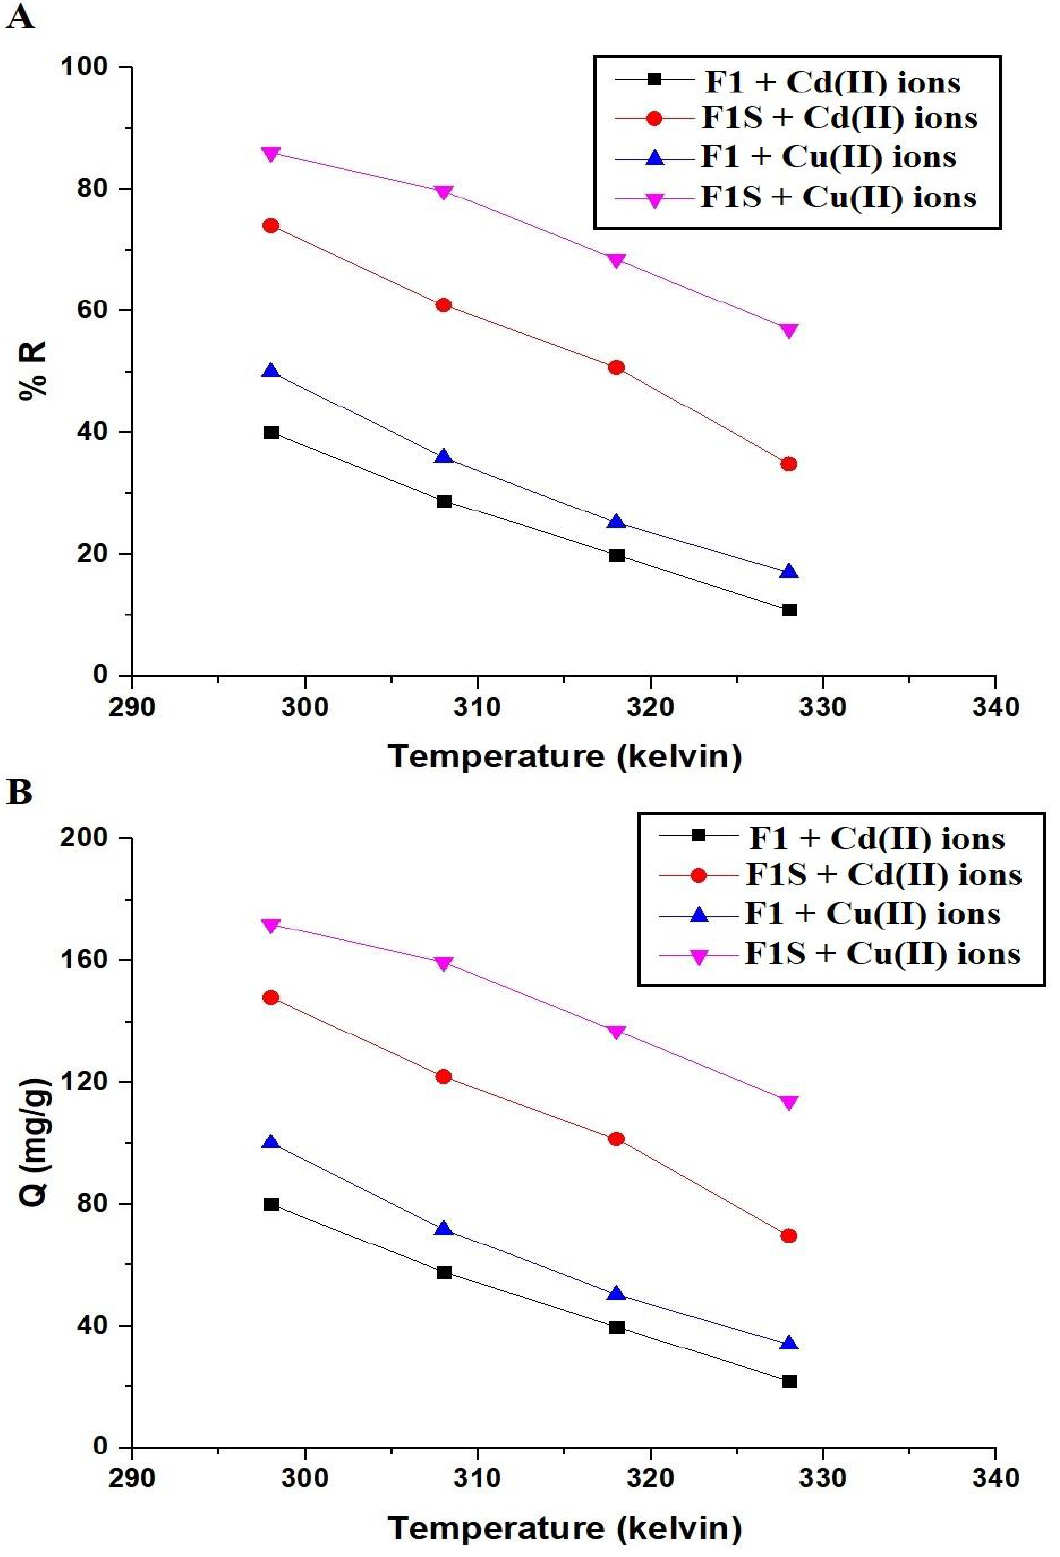
Figure 9. The effect of adsorption temperature on the % removal of copper and cadmium ions ( A ) and the uptake capacity of the F1 and F1S samples ( B ). Experimental conditions: concentration = 200 mg/L, volume = 40 mL, pH = 7.5, amount of adsorbent = 0.04 g, and time = 80 min.